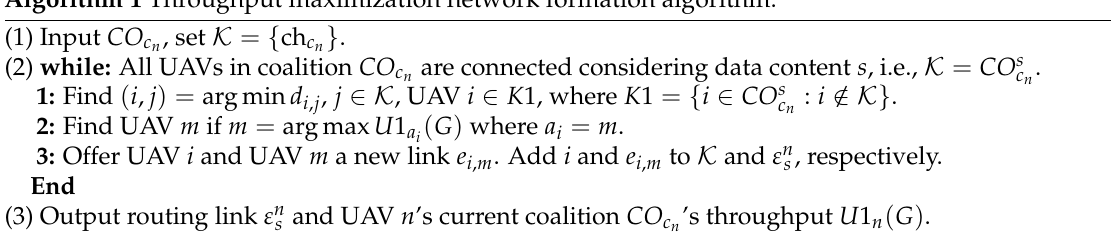
Algorithm 1 Throughput maximization network formation